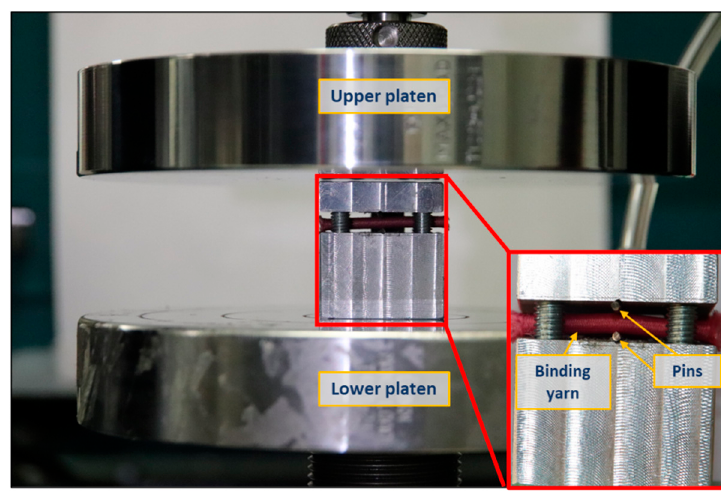
Figure 2. Testing setup on a universal testing machine for Poisson’s ratio measurement.